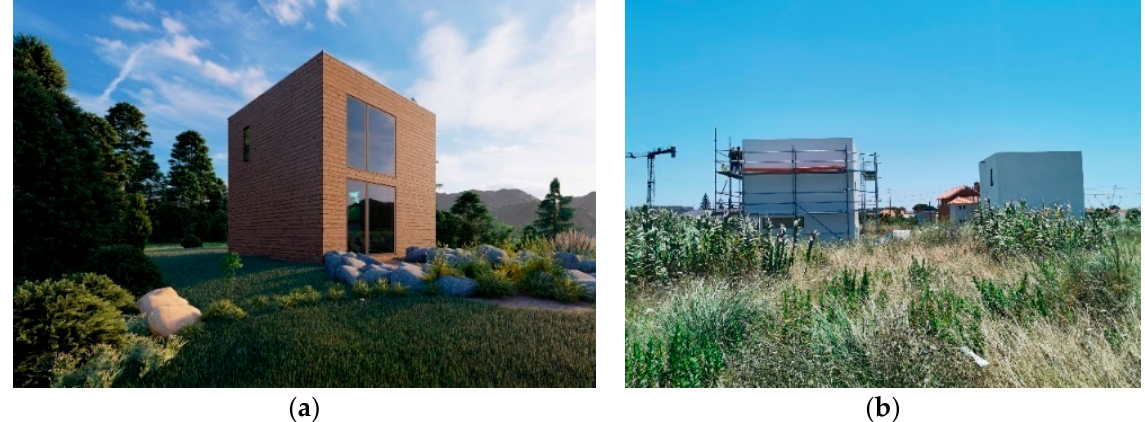
Figure 2. Tiny houses case study: ( a ) 3D design view of the tiny houses; ( b ) tiny houses under construction.